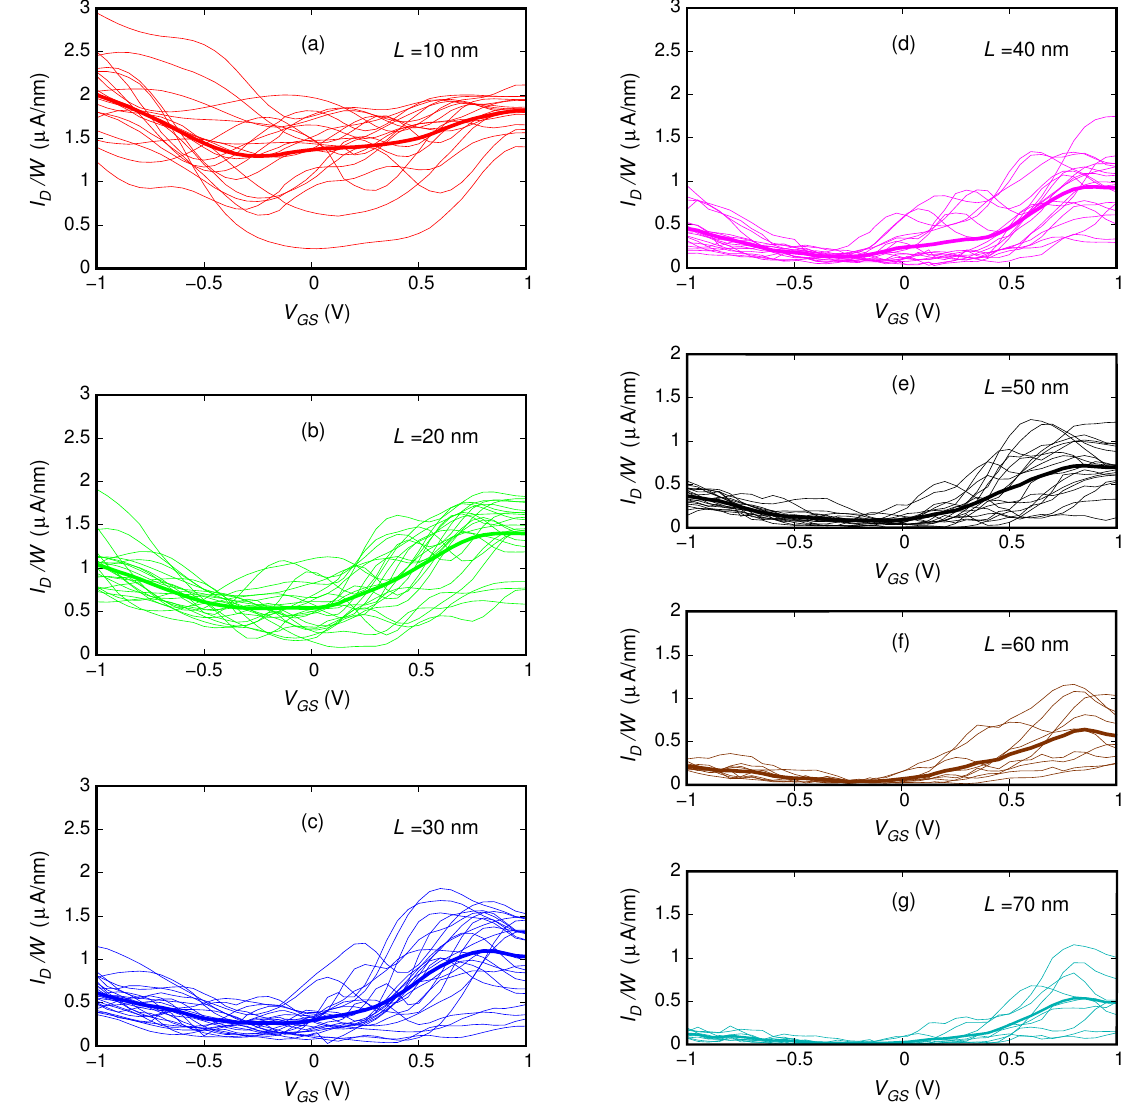
Figure 3. Transfer characteristics (obtained for V DS = 0.1 V) of the double-gate field-effect-transistor based on a graphene ribbon with a 0.6% boron concentration over a length of ( a ) 10 nm, ( b ) 20 nm, ( c ) 30 nm, ( d ) 40 nm, ( e ) 50 nm, ( f ) 60 nm, and ( g ) 70 nm . The thin lines correspond to the individual realizations of the dopant distribution, while the thick lines correspond to the average. The current value was divided by the ribbon width W = 3.81 nm in order to represent the current